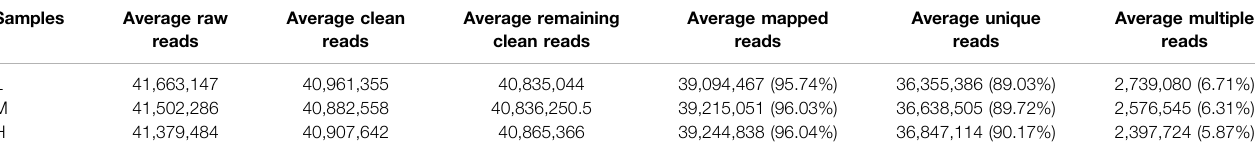
TABLE 2 | Summary of the RNA-seq data.